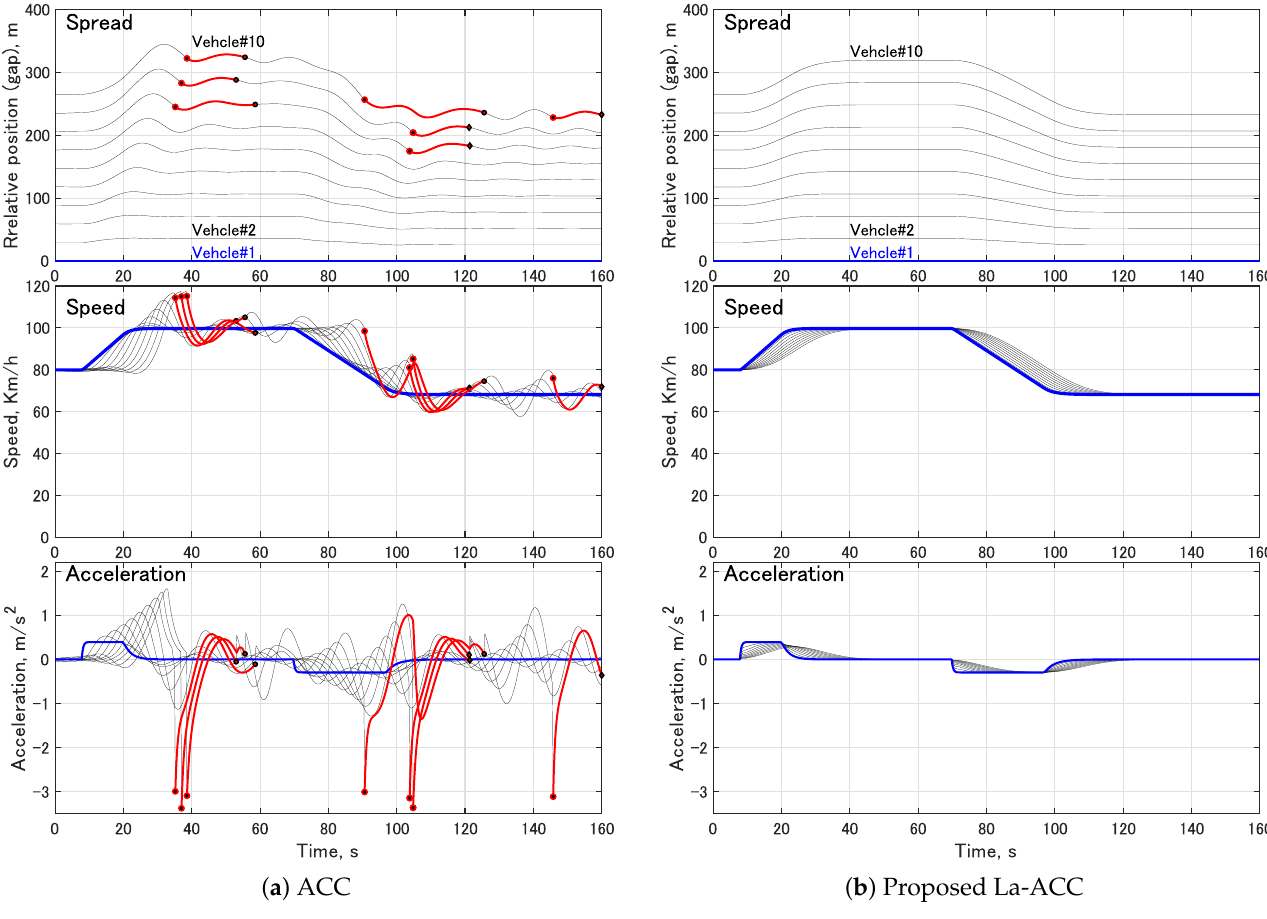
Figure 4. Flowing behavior of ten vehicles in a platoon, where they are all controlled by ( a ) ACC and ( b ) La-ACC. The red curves show the deactivated period of ACC when they are driven by a human